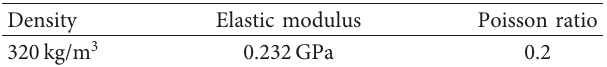
Table 9: Material parameters of core at reference